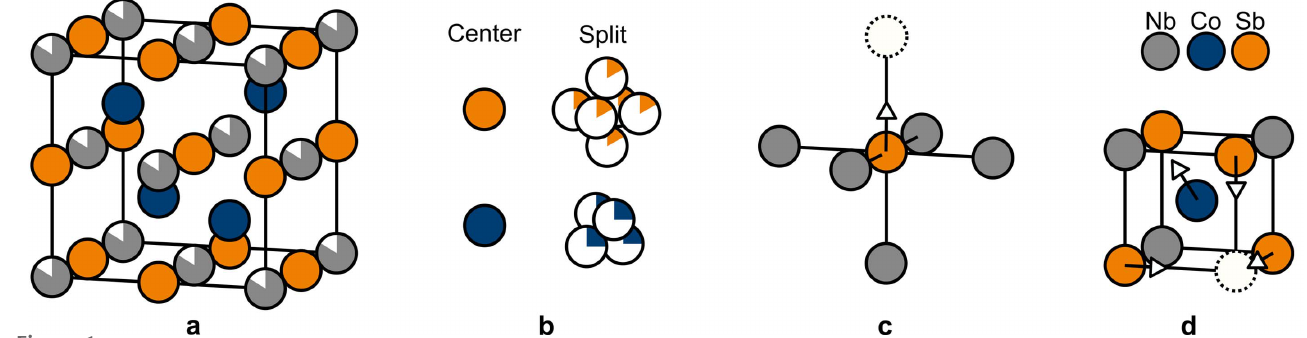
Figure 1 Crystal Structure of Nb 1 (cid:2) x CoSb. ( a ) Unit cell of the average structure. Blue: Co, grey; Nb, orange: Sb. Partial shading indicates occupancy. ( b ) Two models have been tested, one with Sb and Co at the ideal half-Heusler positions and one with off-centred Sb and Co (exaggerated in the figure). ( c ) Nb 5 Sb elementary block with the Sb displacement indicated by the arrow. ( d ) Local relaxation of Co close to a vacancy with the movements of Sb and Co indicated by arrows.